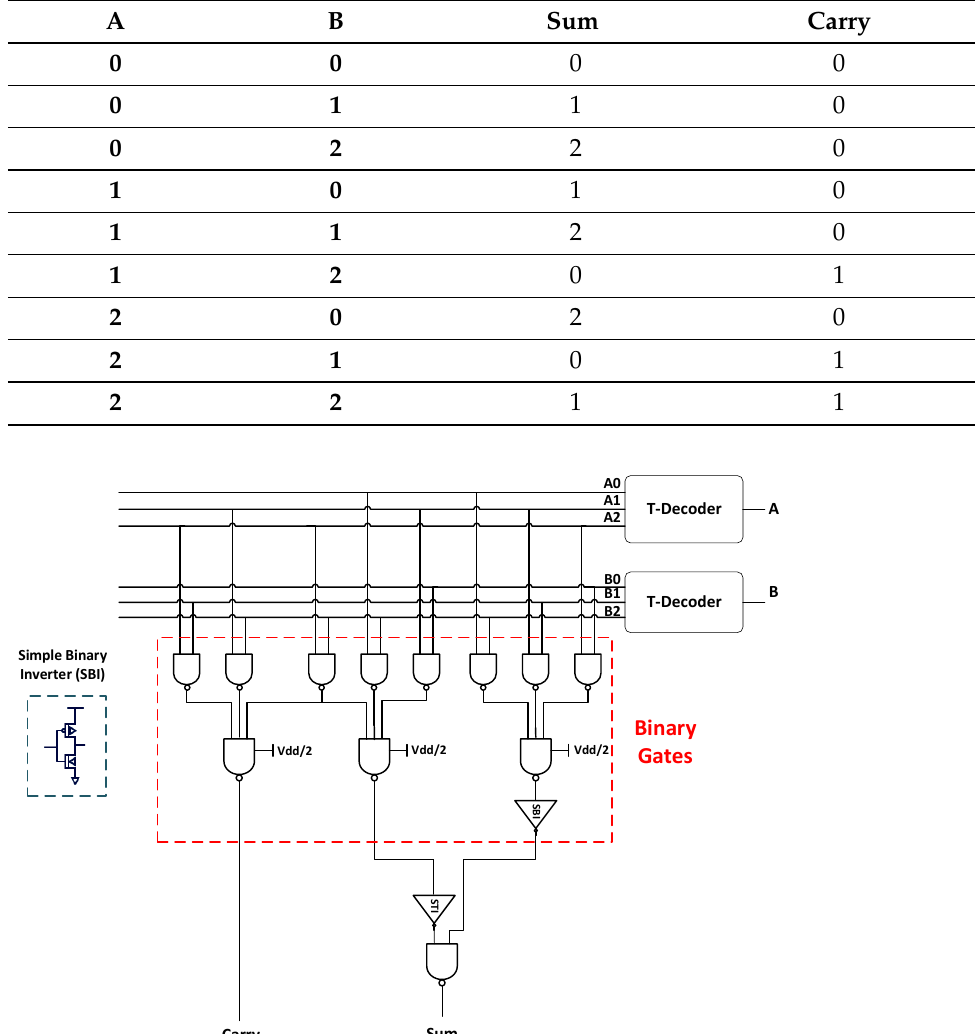
Table 5. Ternary full adder truth table.